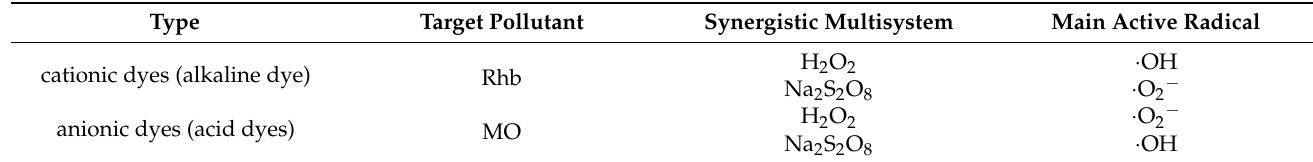
Table 6. Main reactive radicals of different synergistic